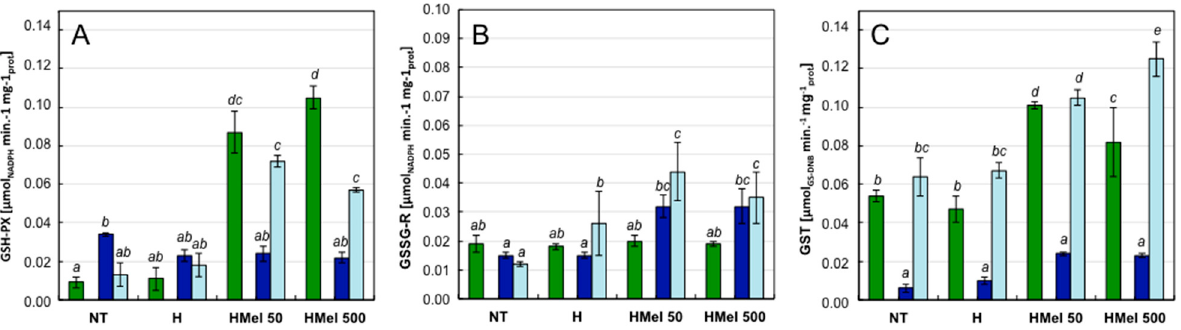
Figure 7. Effect of different corn seed hydropriming treatments on the glutathione-dependent detoxification enzymes activities: GSH-PX ( A ), GSSG-R ( B ), and GST ( C ) in the axes isolated from non-treated seeds (NT), and those from hydroprimed with water (H) and with melatonin water solutions in concentrations: 50 µ M (HMel 50) and 500 µ M (HMel 500). The seeds were imbibed/germinated in water at 5 ◦ C in darkness for 14 days (S [ (cid:4) ]—chilling stress),